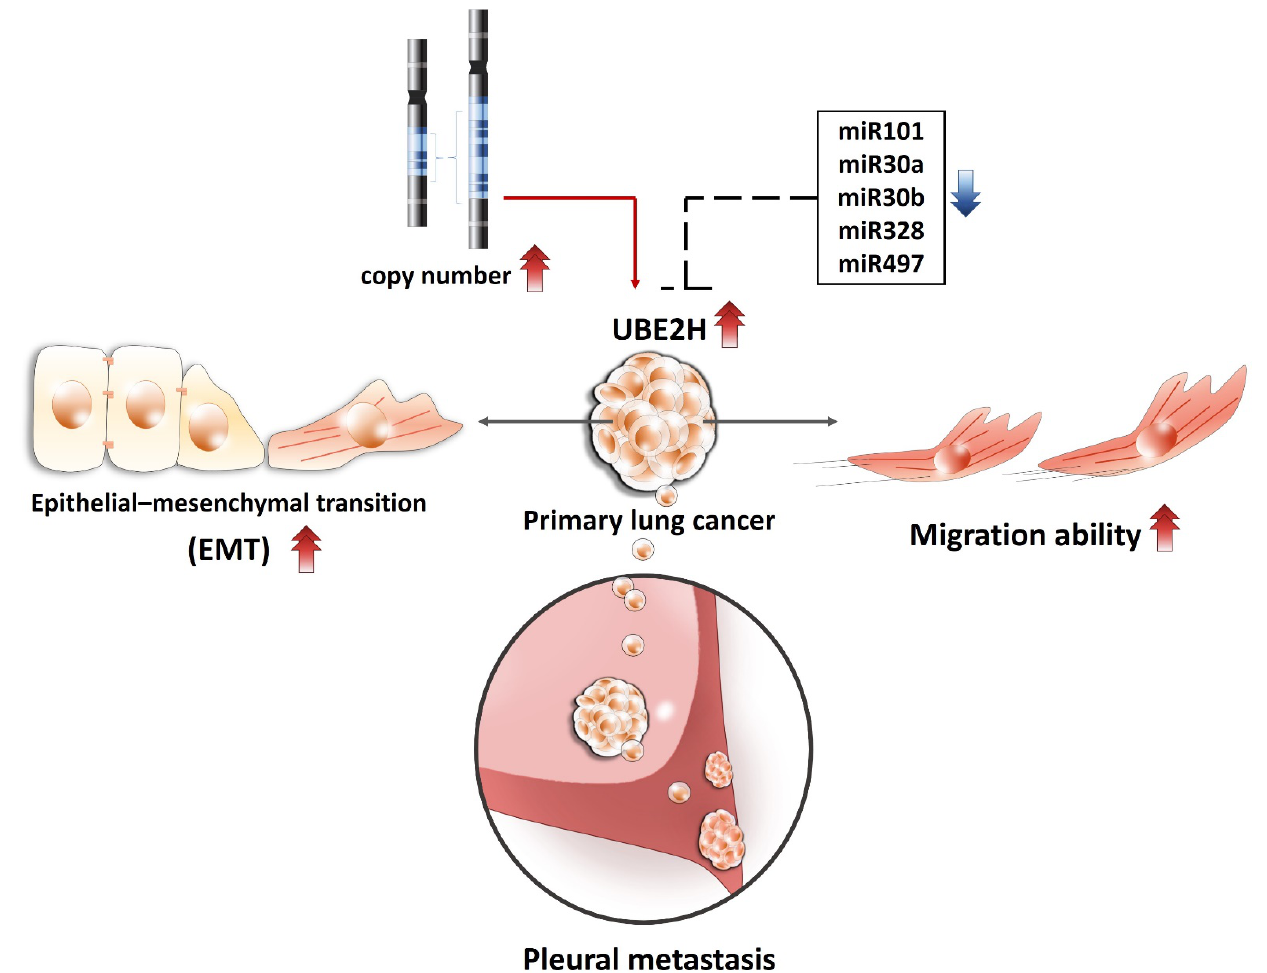
Figure 5. The proposed mechanisms for how UBE2H regulates lung cancer EMT and metastasis and UBE2H is regu- lated.